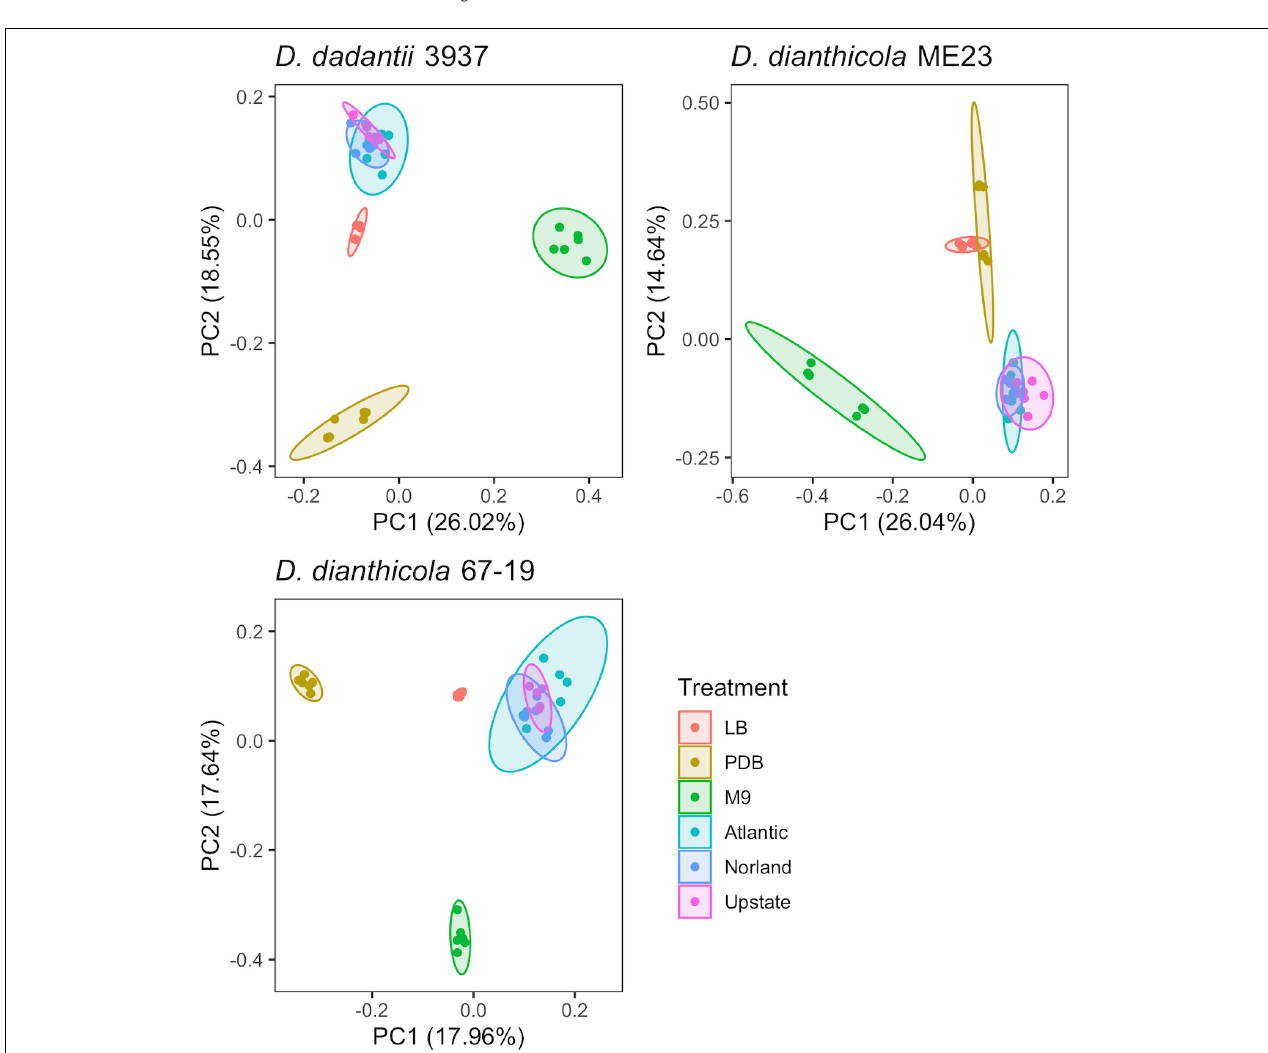
FIGURE 1 | PCA of experimental samples based on fitness values calculated for D. dadantii 3937, D. dianthicola ME23, and D. dianthicola 67–19. Available fitness values for each sample, respectively: N = 3,705; 3,761; 3,528. Superimposed ellipses are based on a multivariate t-distribution.